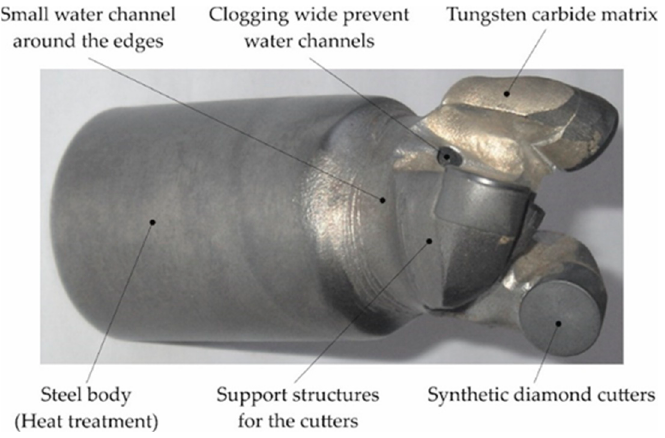
Figure 1. PDC small-diameter bit used in underground drilling.